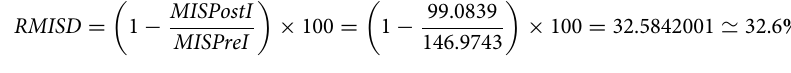
Table 3. Summary of the means of each observation time on the right colon and comparison of each one with the control time: all comparisons presented statistically significant differences.